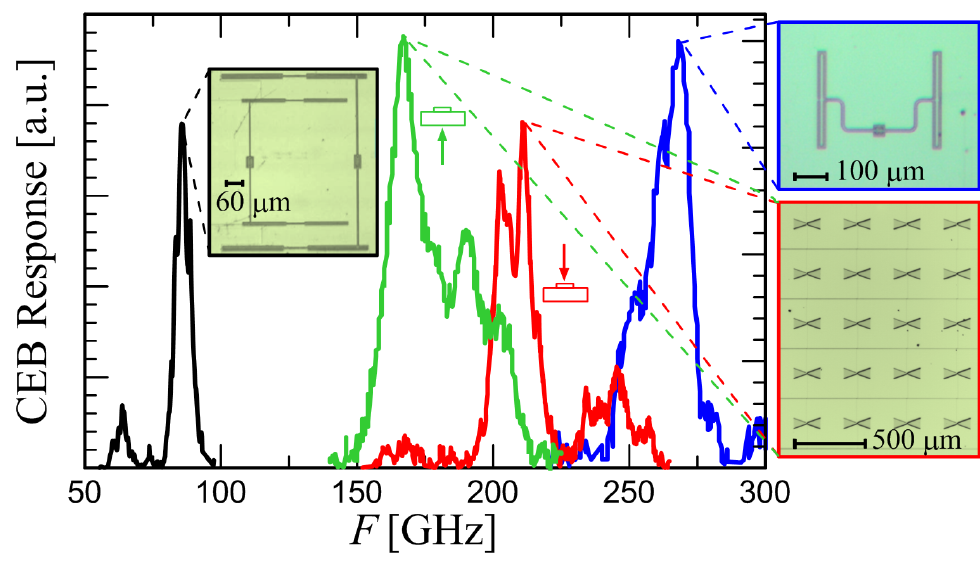
Figure 4. Frequency response of three resonant CEB structures, measured by YBCO Josephson generators. The photographs show the elemental structure of the studied